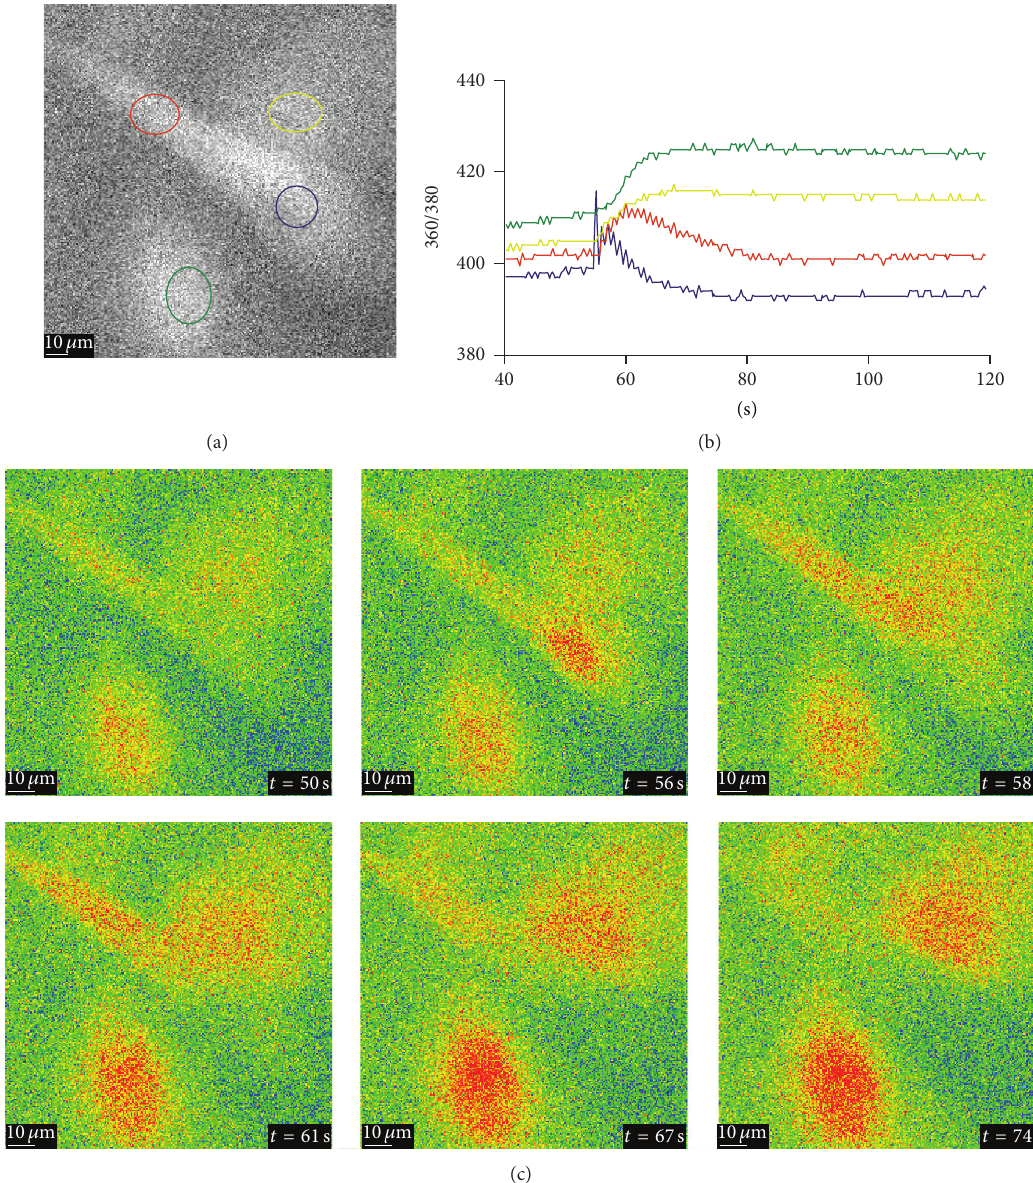
Figure 4: Calcium signaling upon mechanical stimulation of a single cell of the aLC explant culture, showing the [ Ca 2+ ] involvement of intercellular connections. The traces (b) represent the time courses of the 360/380 ratio (𝑅) , proportional to [ Ca 2+ ] correspond to the regions of interest (ROI) shown in the B&W image (a) in the same colors. (c) A series of the 360/380 ratio images at the time points are indicated. The values for 𝑅 are color coded with blue/green representing low ratio values and yellow/red representing high ratios (explant growth time: 14